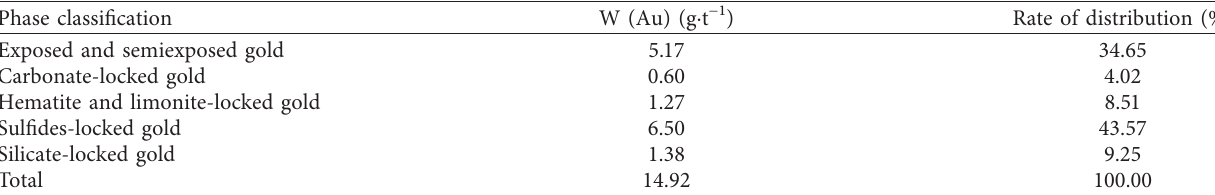
Table 3: Gold phase analysis of the sample.